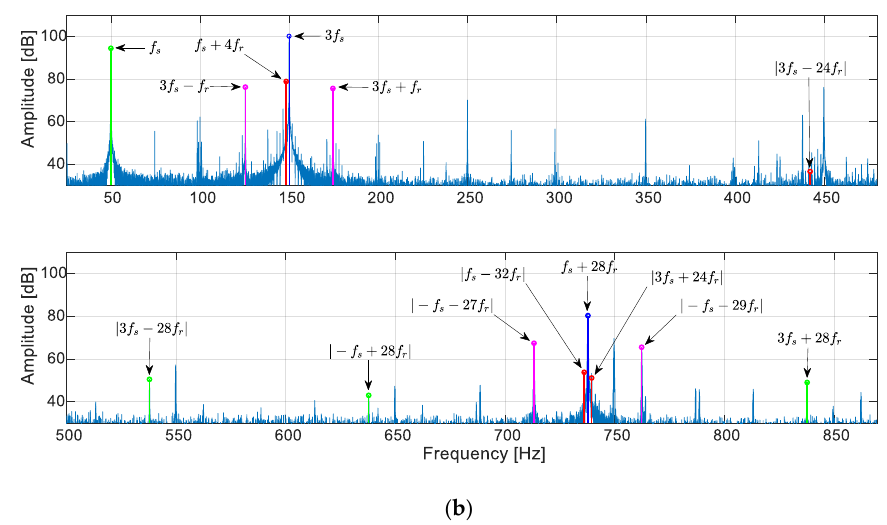
Figure 17. ZSC spectrum measured during laboratory tests of the motor with the wye winding connection; ( a ) healthy (noise level ≈ 38 dB), ( b ) rotor eccentricity (noise level ≈ 35 dB). Table 5. Results of harmonic amplitude measurements of characteristic frequencies for a given type of eccentricity, obtained through experimental results of a motor with delta and wye connections with a neutral wire stator winding configuration.